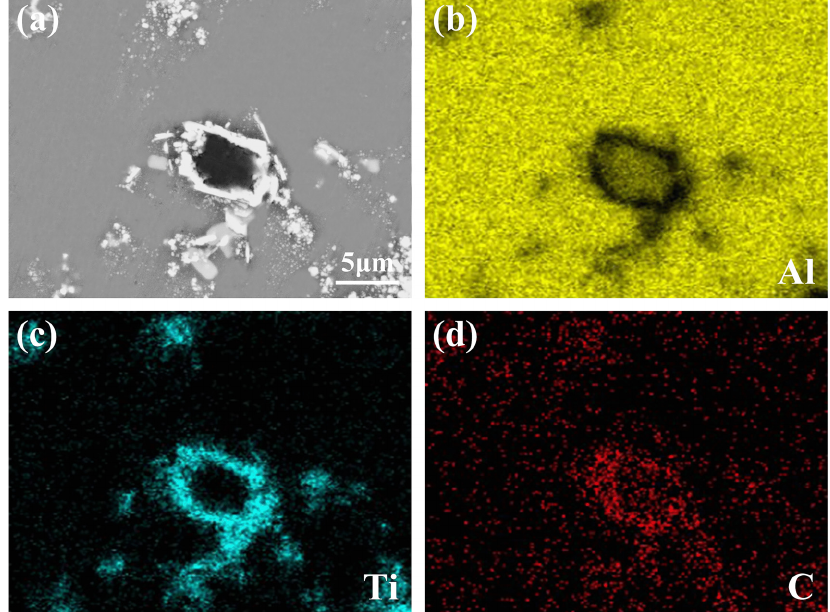
Figure 13. EDS mapping analysis of core–shell particles in Al-4Ti-1D (6 μ m): ( a ) microstructure and ( b – d ) mapping micrographs for Al, Ti, and C elements. Figure 14. The core–shell particles in Figure 14a,c correspond to the core–shell particles in